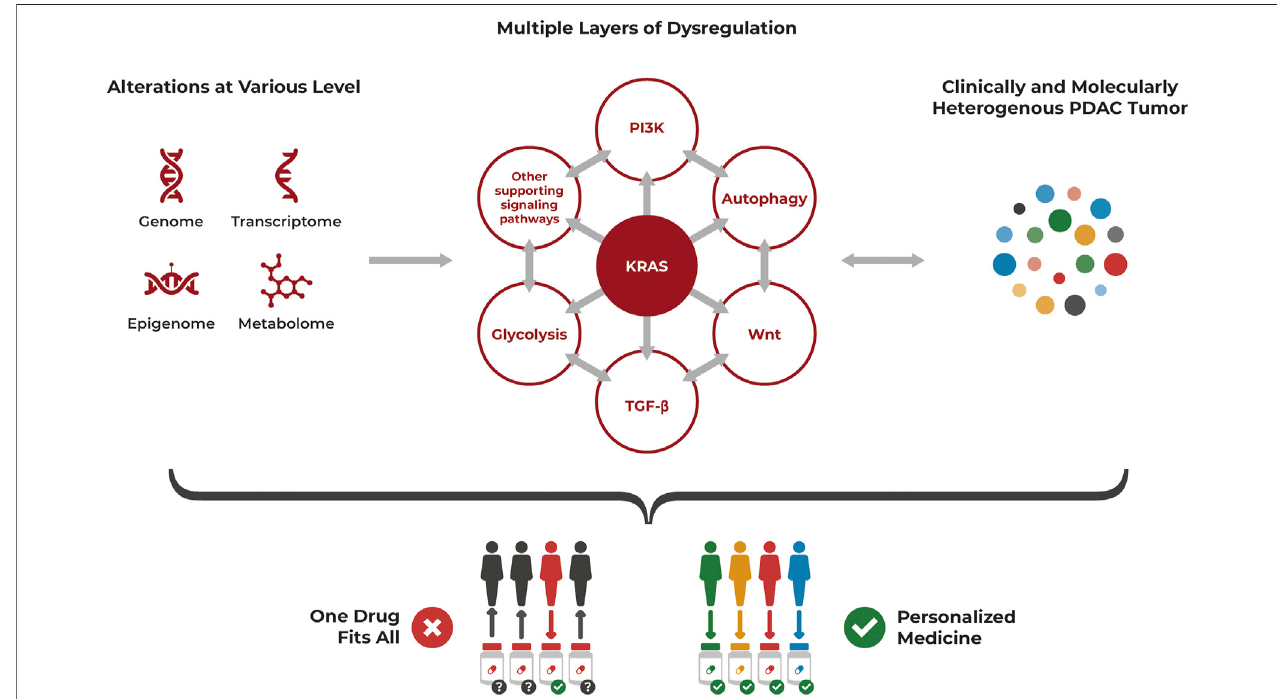
FIGURE 2 | PDAC heterogeneity requires a personalized approach for treatment. PDAC is a highly heterogenous cancer at the cellular level, often driven by KRAS mutations but with multiple layers of dysregulation affecting each other, that also need to be considered. Alterations occur at various levels including genomic, transcriptomic, epigenomic and metabolomic aberrations. The resulting clinically and molecularly heterogenous tumor is unlikely to be successfully treated with a “ one drug fi ts all ” approach but requires a personalized approach speci fi cally targeting its individual dysregulations.